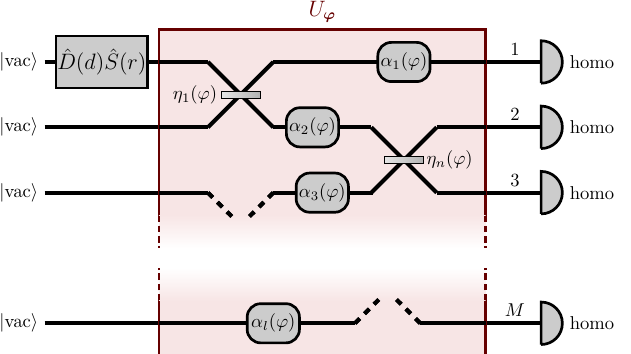
Figure 5. Scheme of the setup described in Section 3. A squeezed coherent state is injected in the first input port of a network ˆ U ϕ which depends on a parameter ϕ that is generally distributed among multiple components of the network. Homodyne detection is performed at each of the output ports. Differently from the setup in Figure 2, no auxiliary stage is required to reach the Heisenberg scaling. Reprinted with permission from ref. [43], © 2022 The